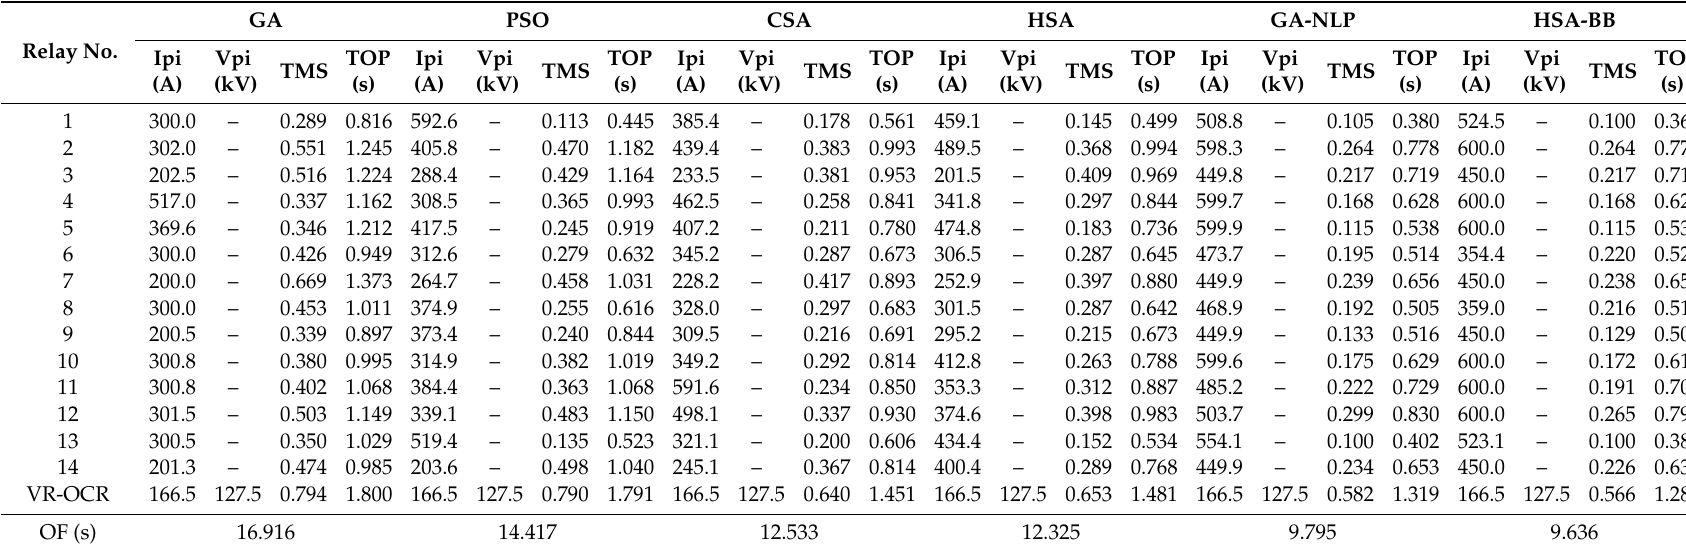
Table 4. Results of 8-bus